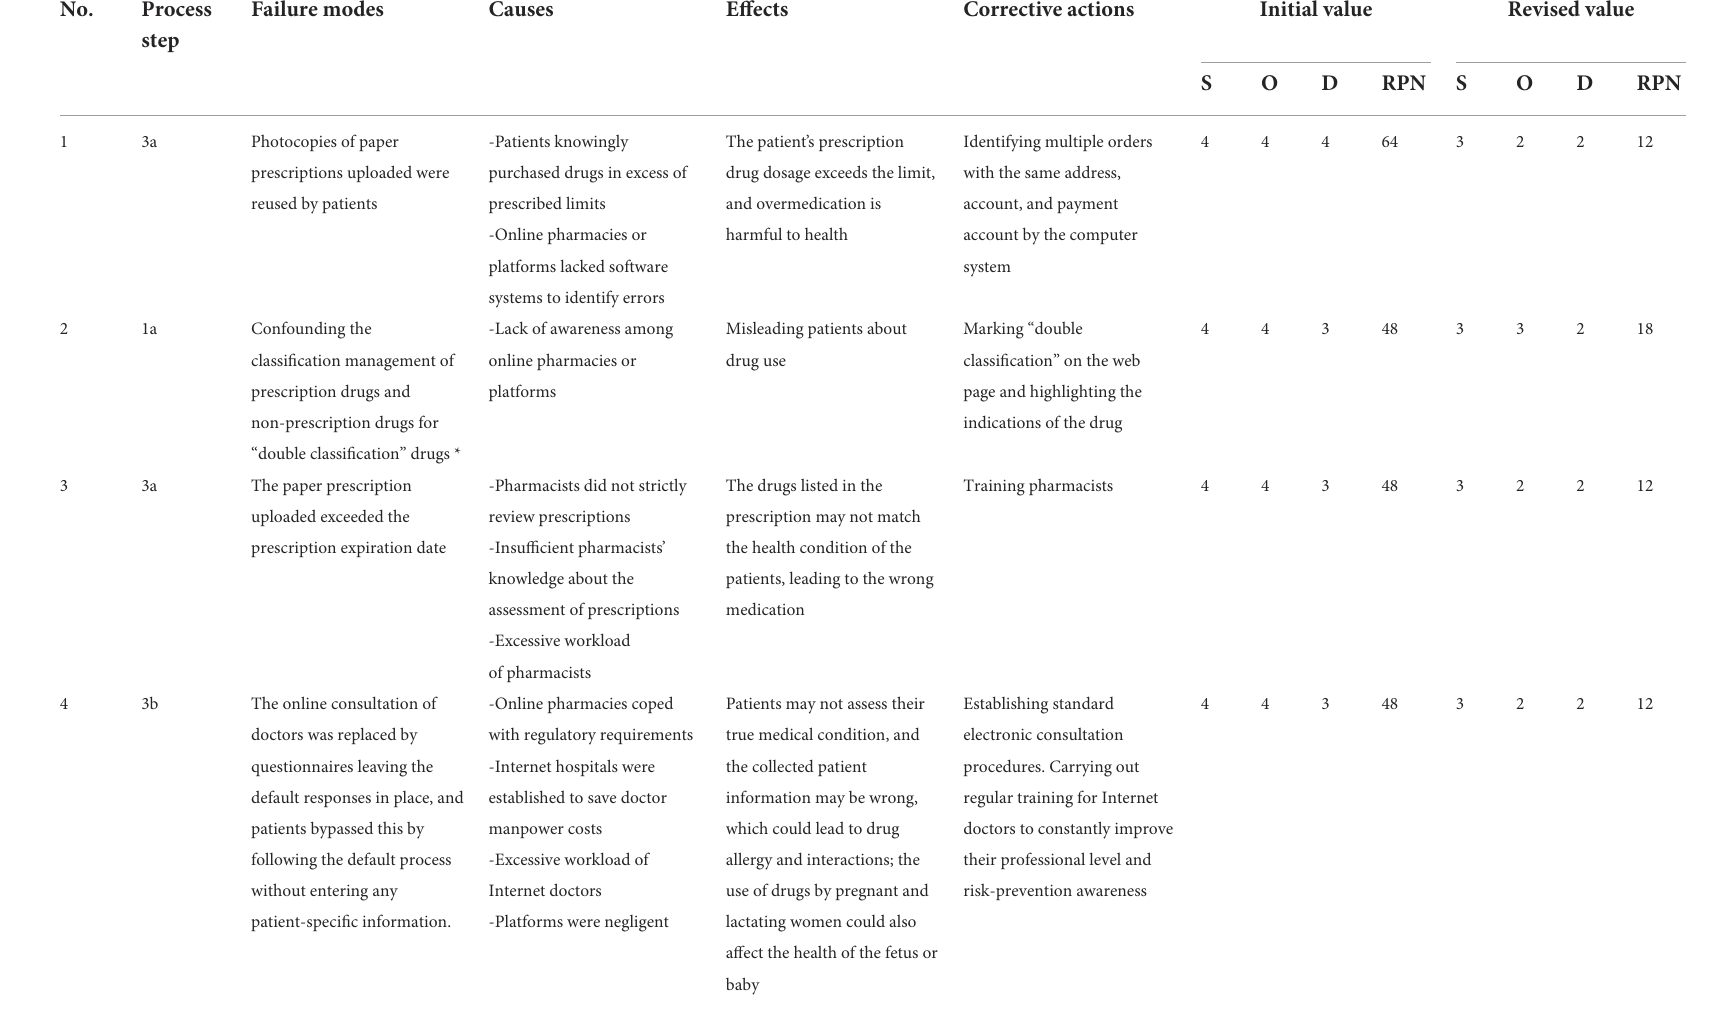
TABLE 2 Top critical failure modes, underlying causes, and corrective